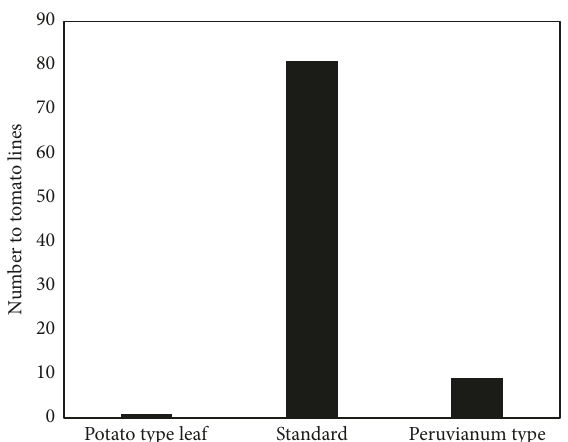
Figure3:Leafshapedistributionofninety-onefresh-markettomato genotypes.